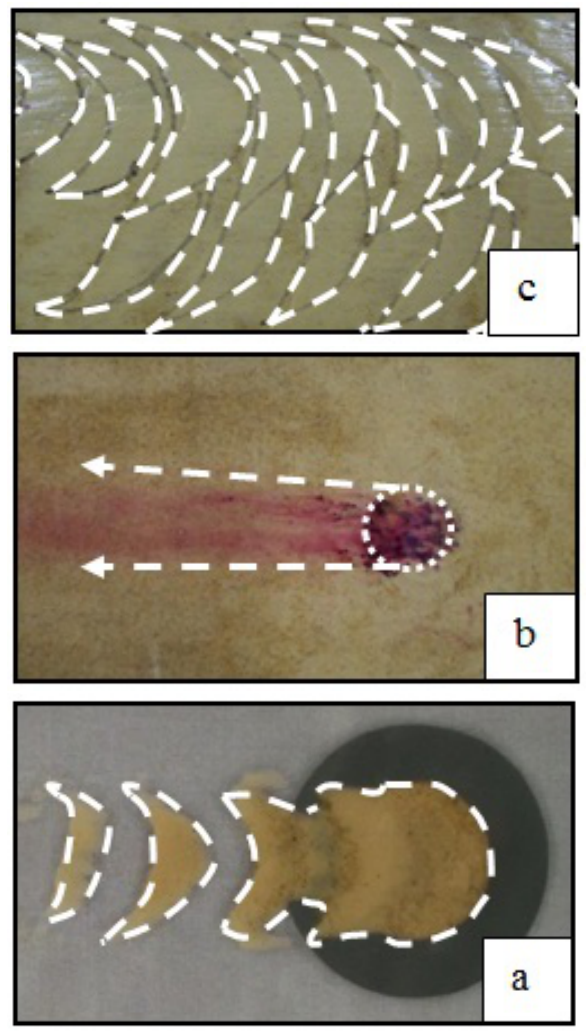
Figure 6: (a) A photographic view of ‘crescent’ deposition zones (b) Visualised soil sample using KMnO 4 dye and (c) Integrated crescent zones in rough